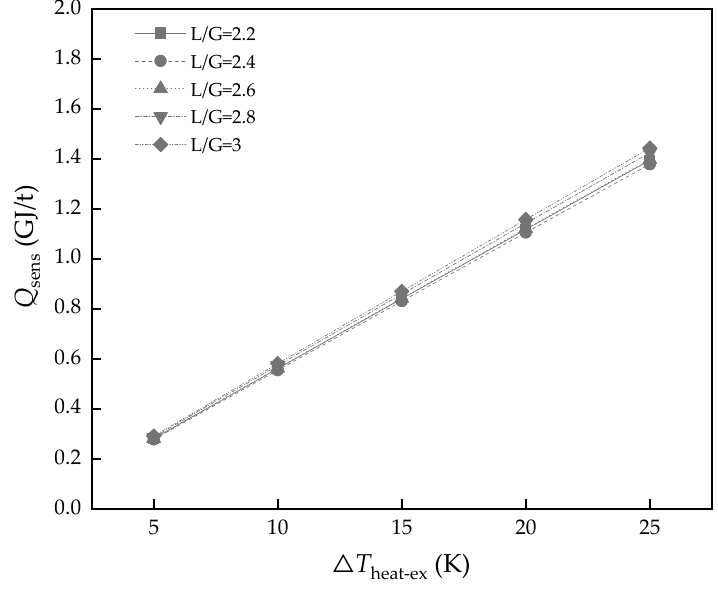
Figure 13. The energy consumption of Q sens with different heat exchanger performances.